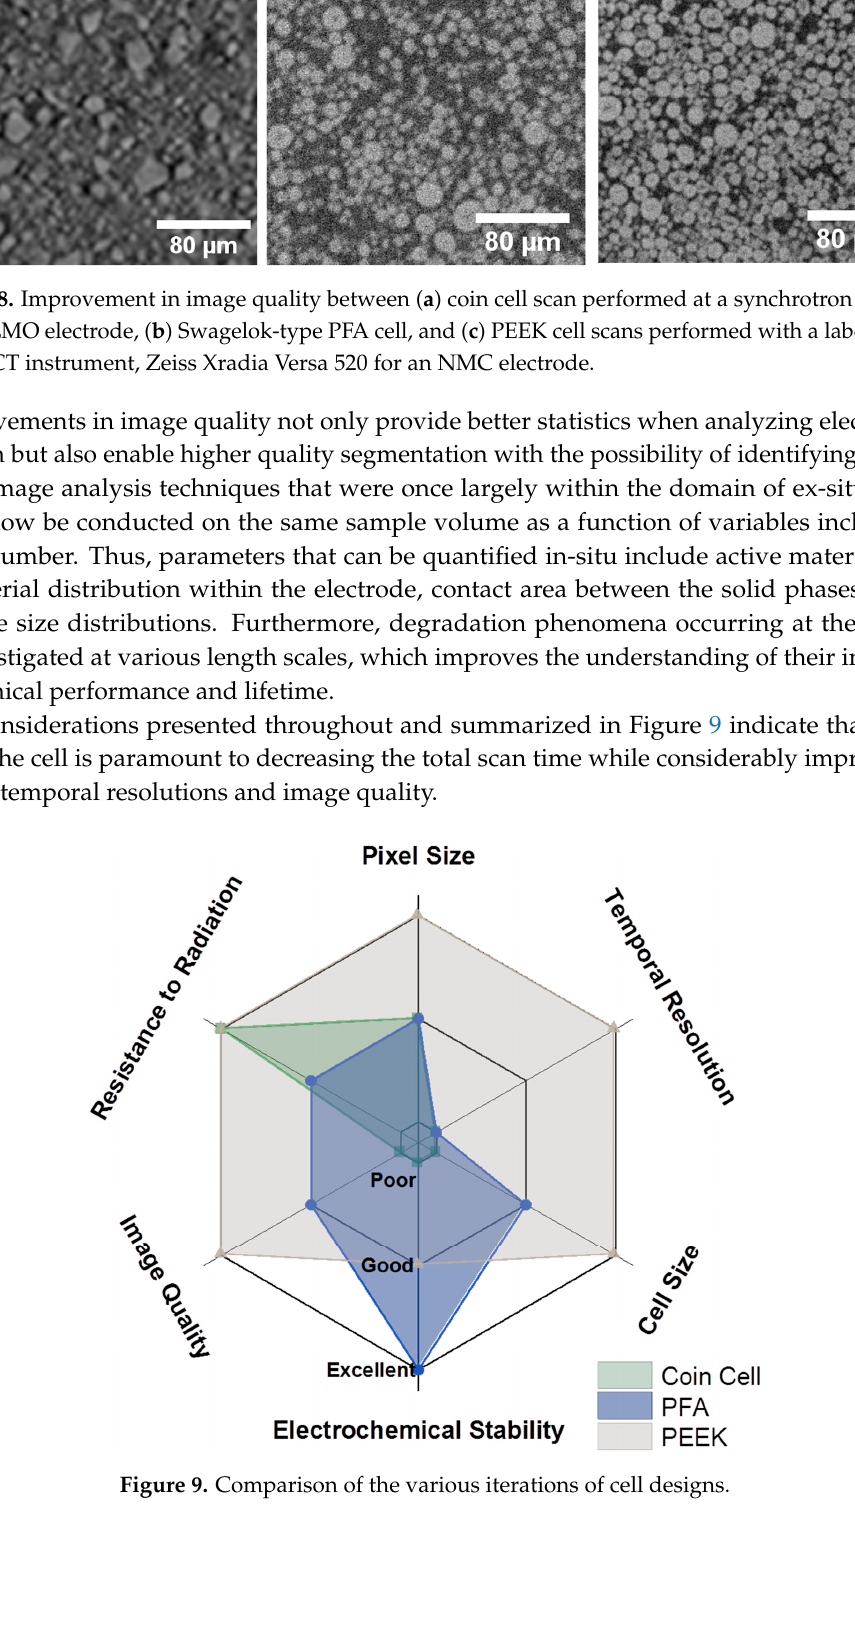
12 of 18 Figure 7. ( a ) Rendering of the 1/32’ PEEK cell. ( b ) Volume rendering of NMC acquired at 20× magnification and ( c ) Li-S electrodes acquired at 40× magnification and the ( d , e ) their respective virtual slices. 2.7. Improvement in Image Quality and Electrochemical Performance through In-Situ Cell Optimization